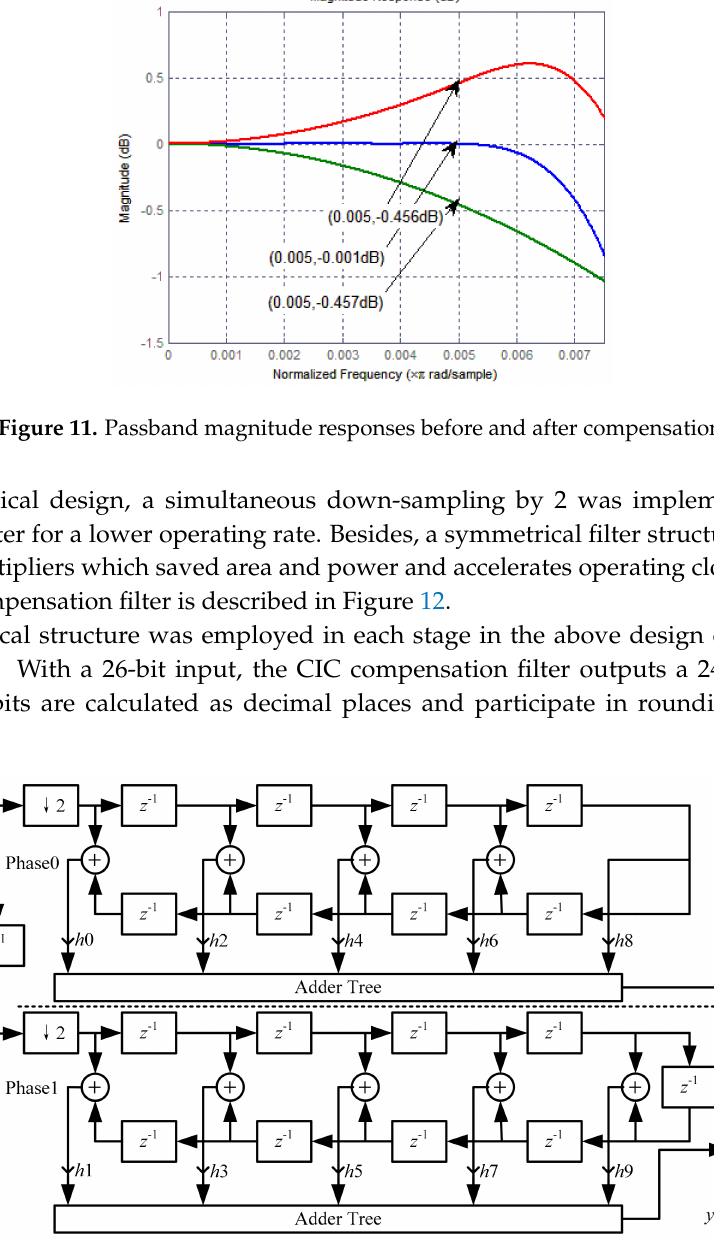
Figure 12. Block diagram of the optimized compensation